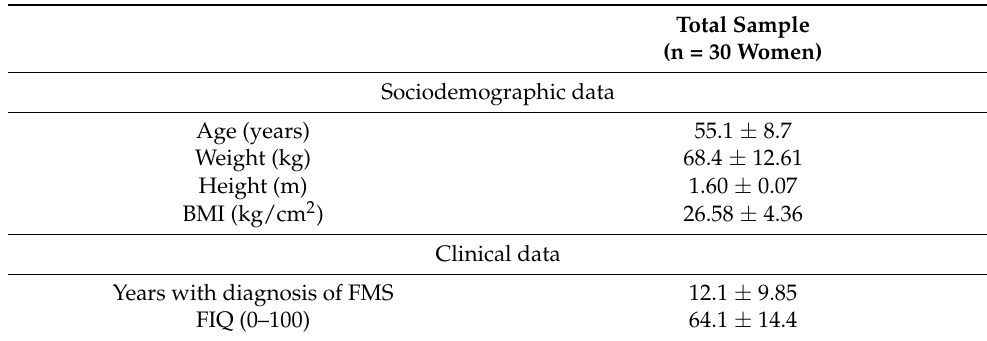
Table 1. Sociodemographic and clinical data of the sample.